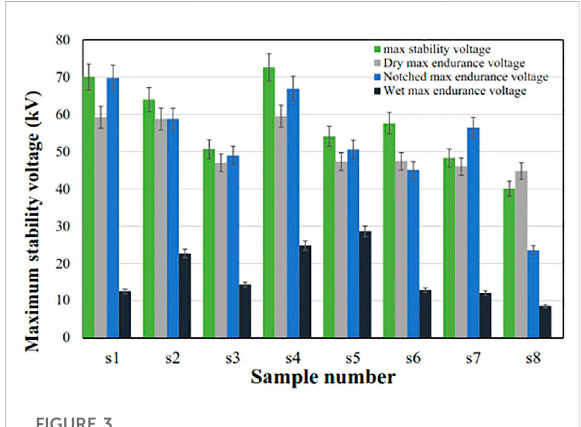
FIGURE 3 Maximum power voltages in different composite